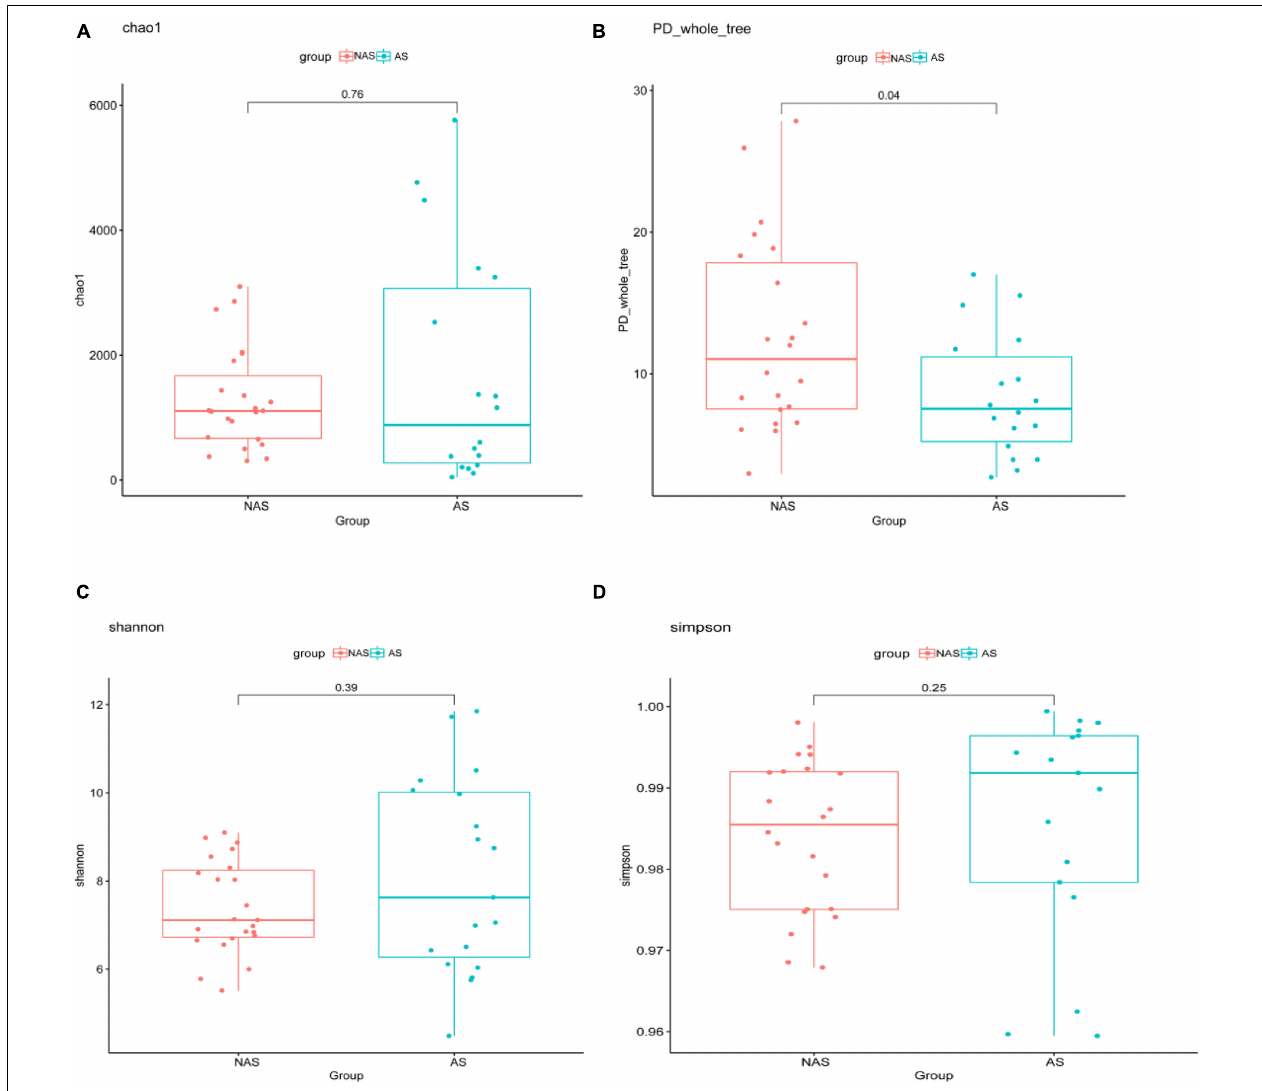
FIGURE 4 | The alpha-diversity box and whisker plot of taxa richness in samples were analyzed by partial 16S rDNA sequencing. Index of Chao 1 (A) , PD_whole_tree (B) , Shannon (C) , and Simpson (D) was calculated